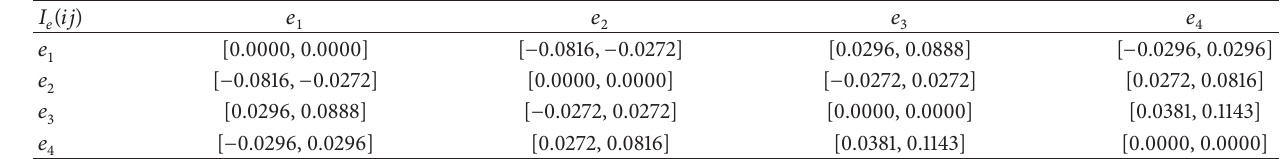
Table 4: Interaction coefficient ranges between any two